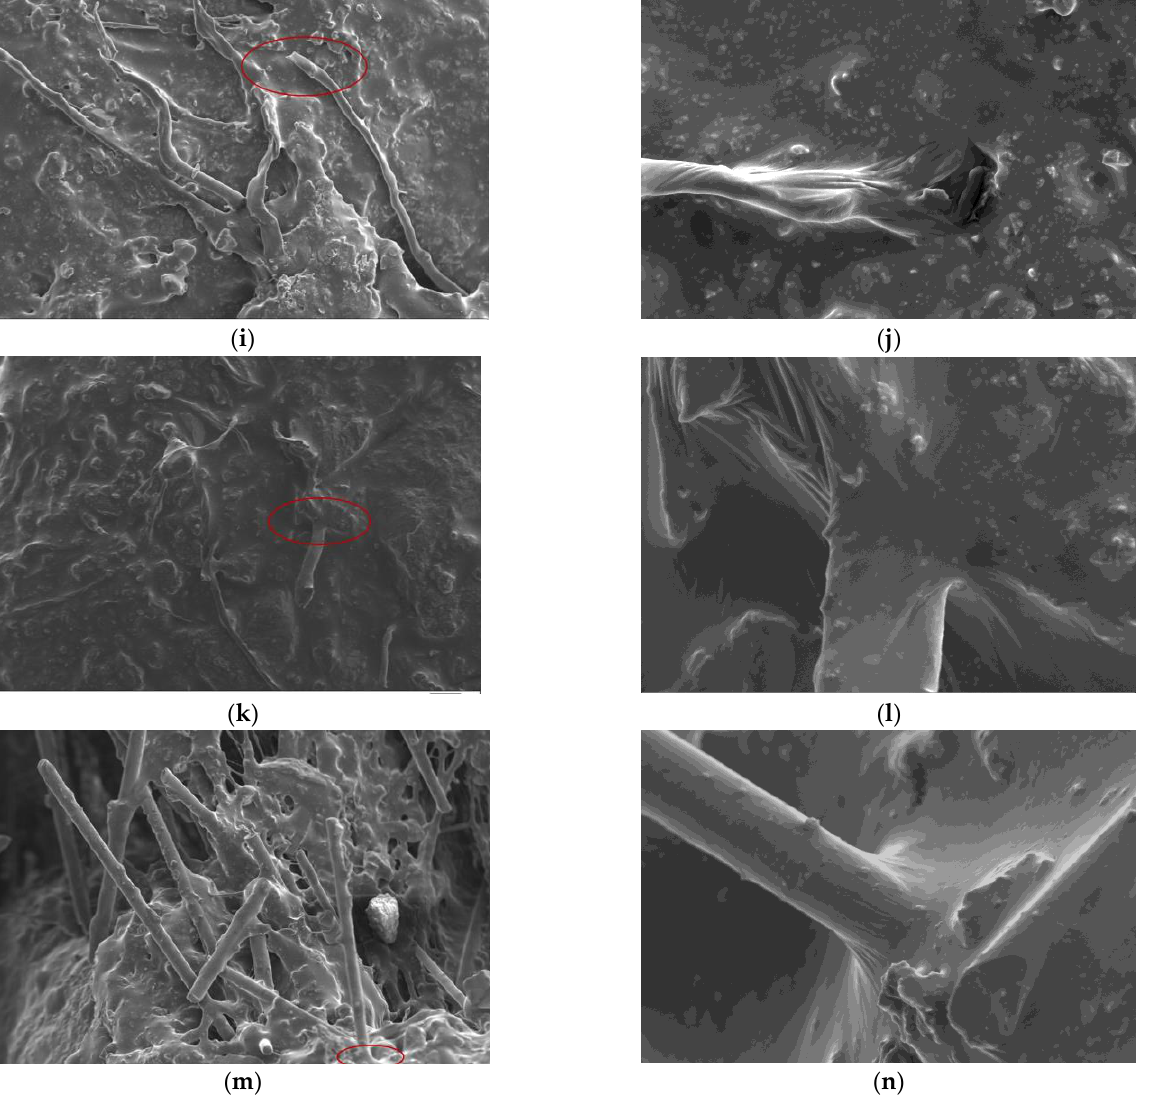
Figure 16. Microscopic Morphology: ( a ) 0.30 wt% GFSMA; ( b ) local zoom of 0.30 wt% GFSMA; ( c ) 0.40 wt% GFSMA; ( d ) local zoom of 0.40 wt% GFSMA; ( e ) 0.45 wt% GFSMA; ( f ) local zoom of 0.45 wt% GFSMA; ( g ) 0.5 wt% GFSMA; ( h ) local zoom of 0.5 wt% GFSMA; ( i ) 0.55 wt% GFSMA; ( j ) local zoom of 0.55 wt% GFSMA; ( k ) 0.45 wt% FFSMA; ( l ) local zoom of 0.45 wt% FFSMA; ( m ) 0.50 wt% BFSMA; ( n ) local zoom of 0.50 wt% BFSMA.